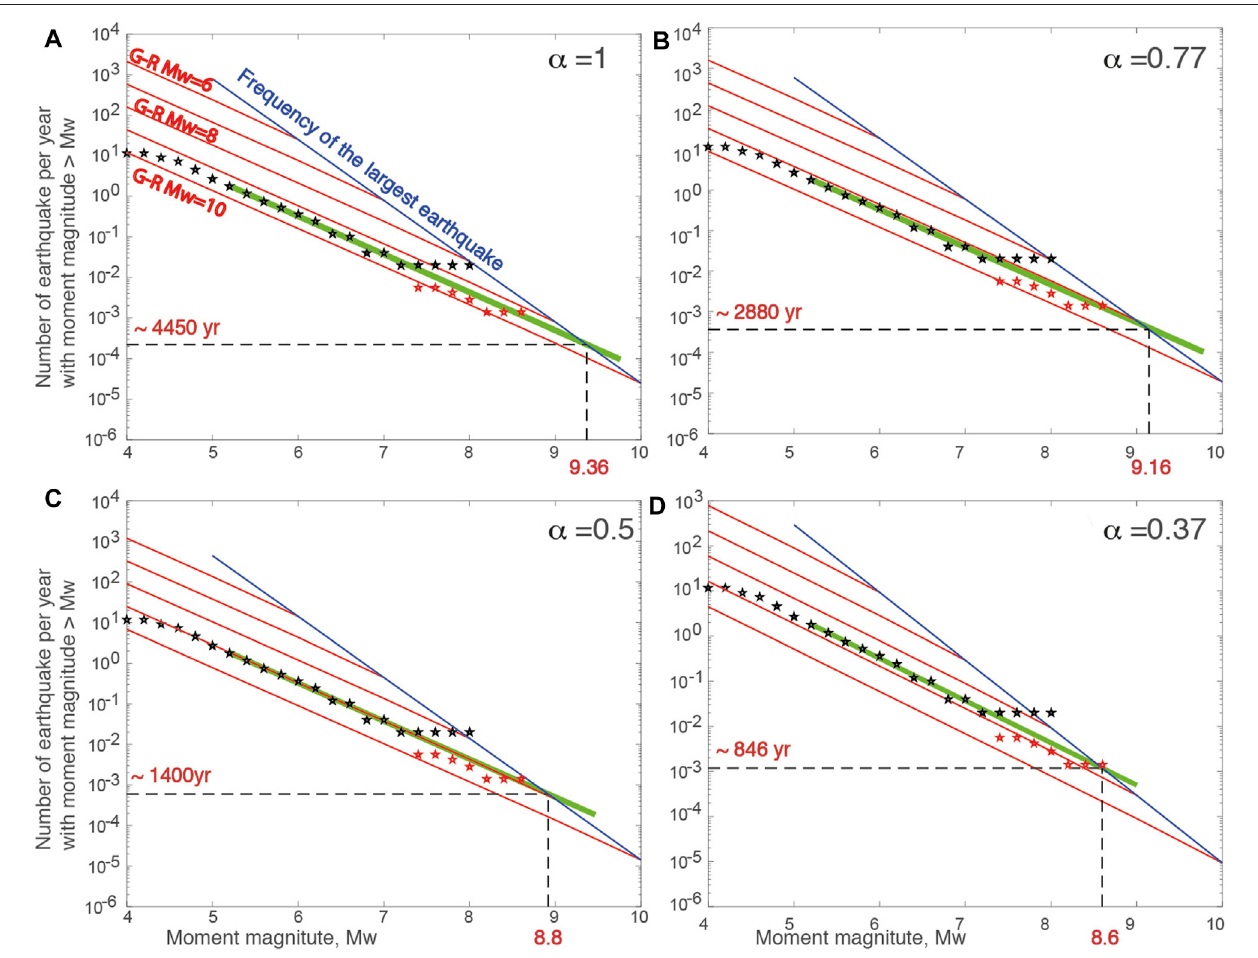
FIGURE 9 | Moment budget closure for the Ecuador – Colombia subduction zone for various seismic/aseismic ratio. The blue line represents the frequency of the maximum magnitude earthquake to ful fi ll the moment budget closure condition. The red lines follow the GR law with a b value of 0.93 (found in the instrumental catalog, Figure 8C ) and show where the seismicity should lie given an earthquake with maximum magnitude of 6, 7, 8, 9, or 10 from top to bottom, respectively. We assume differentamountofseismicvs.aseismicslip: (A) α (cid:1) 1,transientslipisfullyseismic, (B) α (cid:1) 0.77(30%ofthetransientslipisaseismic), (C) α (cid:1) 0.5(transientslipishalf seismic and half aseismic), and (D) α (cid:1) 0.37, lower α limit to be consistent with an Mw (cid:1) 8.6 event like in 1906.